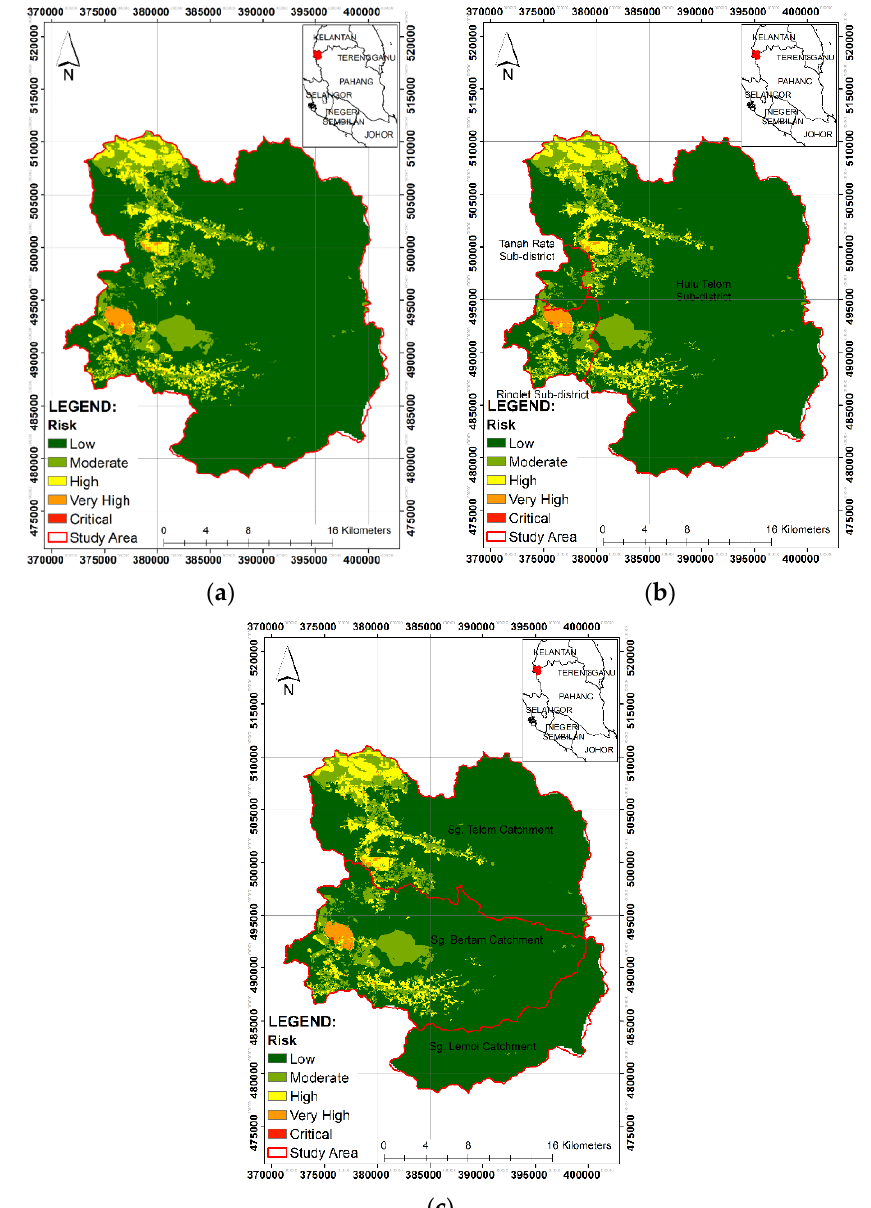
Figure 7. Soil loss risk map for Cameron Highlands by ( a ) district, ( b ) sub-district, and ( c ) river catchment.